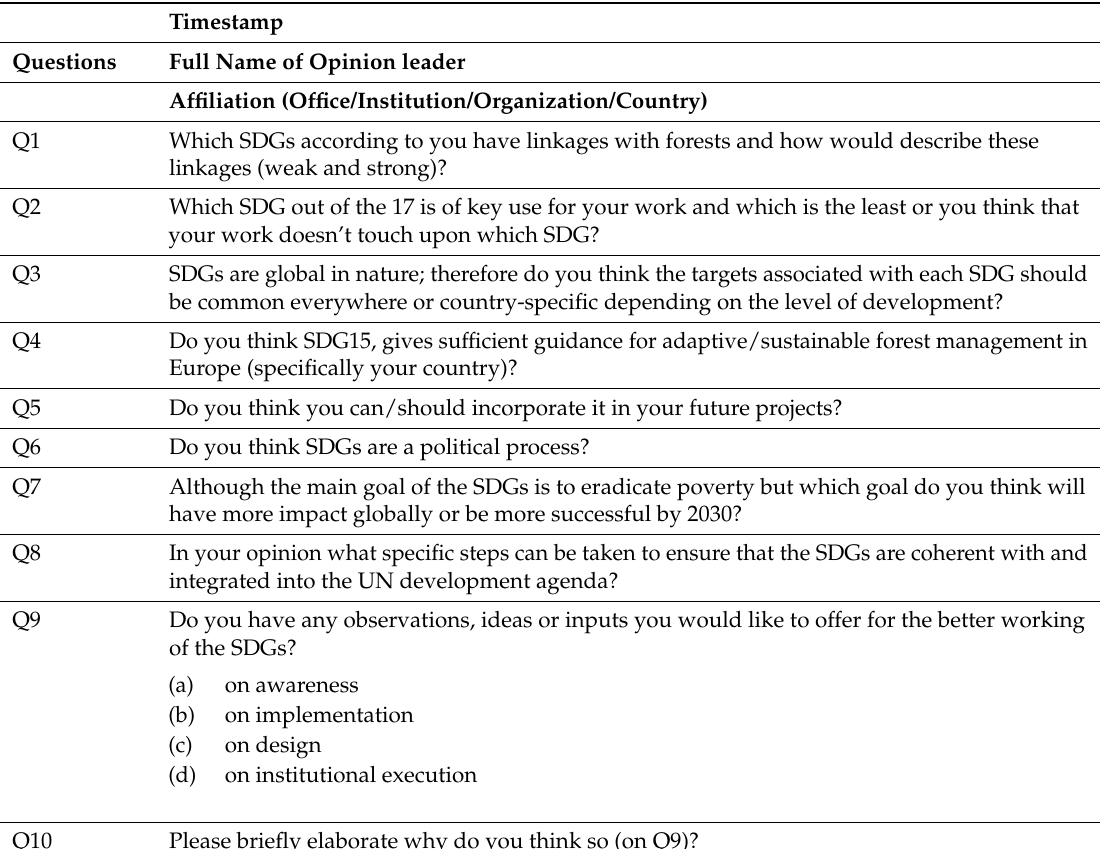
Table A2. The questionnaire for personal interviews on analyzing the perceptions of sustainable forest management (SFM) and its alignment to the global goals among the key stakeholders from the Austrian forestry sector such as forestry institutions, policymakers, research institutes, and international